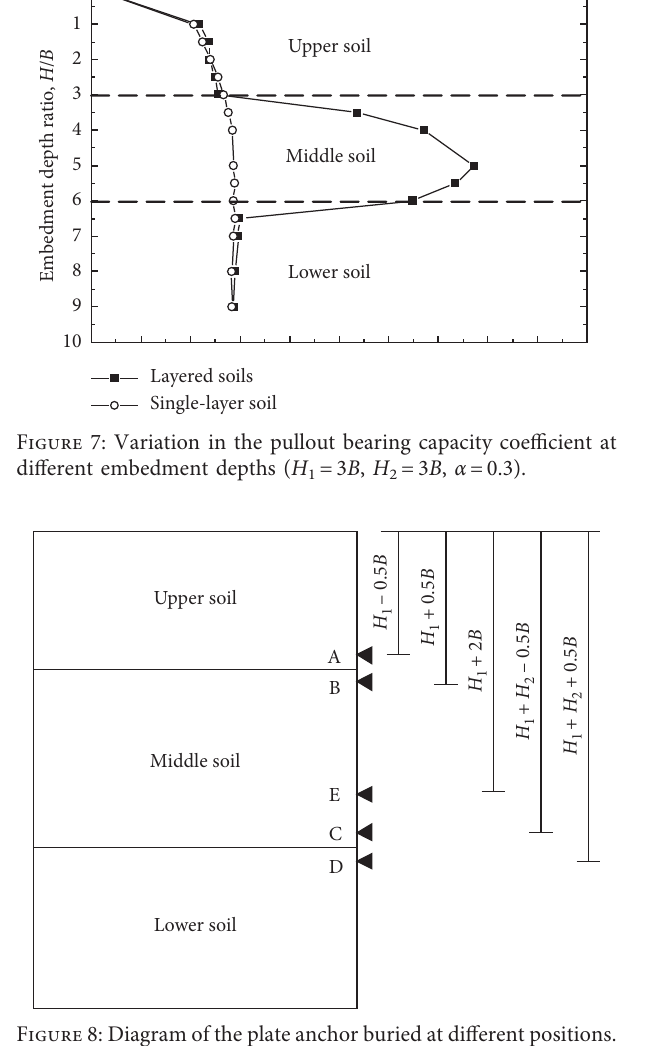
Figure 10: Variation in N c , l with the thickness of the hard middle soil layer H 2 ( H 1 � 3 B , α �